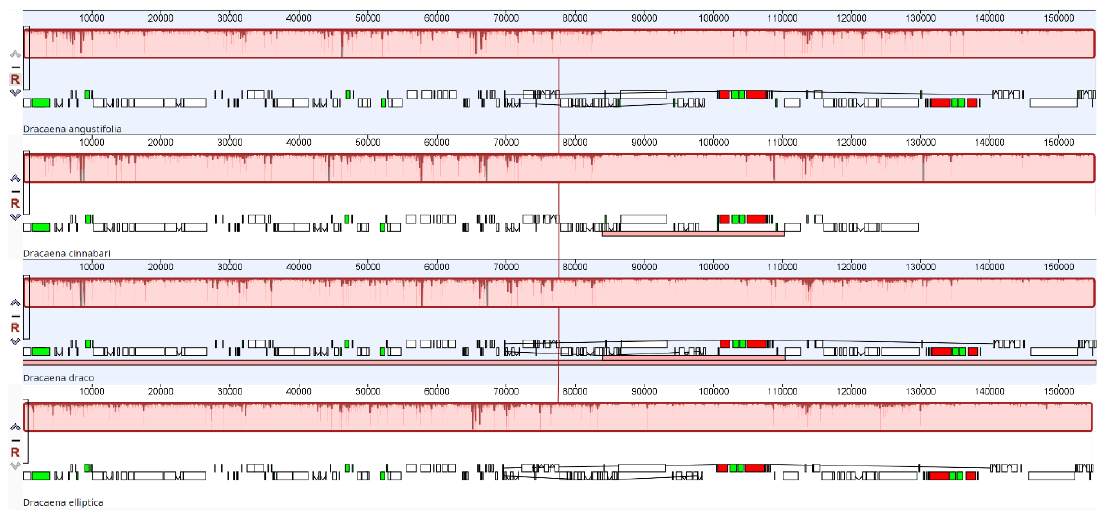
Figure 2. Comparison of four Dracaena chloroplast genomes using a progressive MAUVE algorithm.